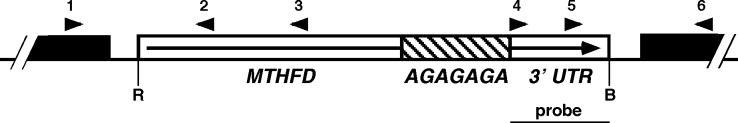
The structure of pugD in the vector P[X97].The 3.4 kb EcoRI-BamHI (R, B) fragment of pugD includes three parts: the 5’ portion from pug+ (MTHFD); the one kb AGAGAGA repeat; and, the putative 3’ UTR from the rab7 region. The arrow indicates the direction of transcription. The solid boxes to either side represent sequences from the white gene of the vector. The probe used for Southern analyses is indicated. Arrow heads represent primers used for PCR. See Materials and Methods for details.